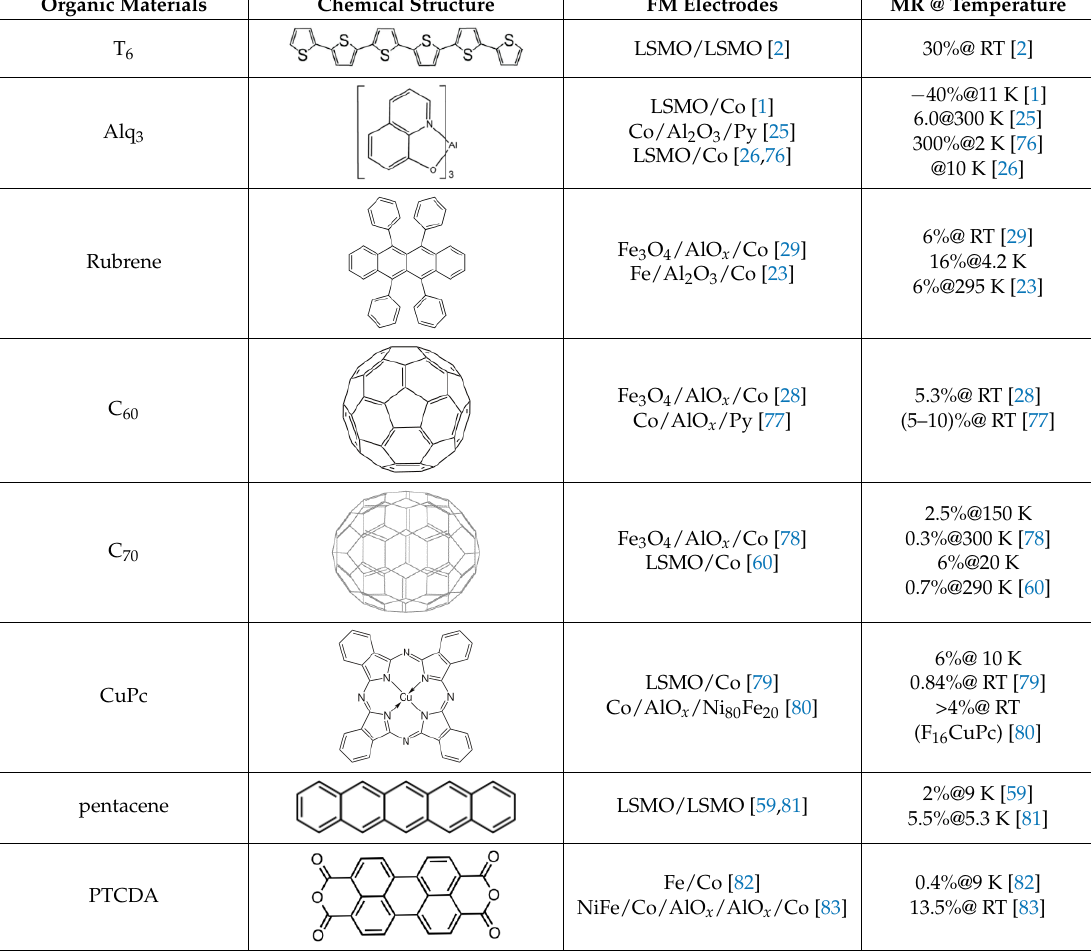
Table 2. Organic molecules and FM electrodes used in spin valves and MR ratio.